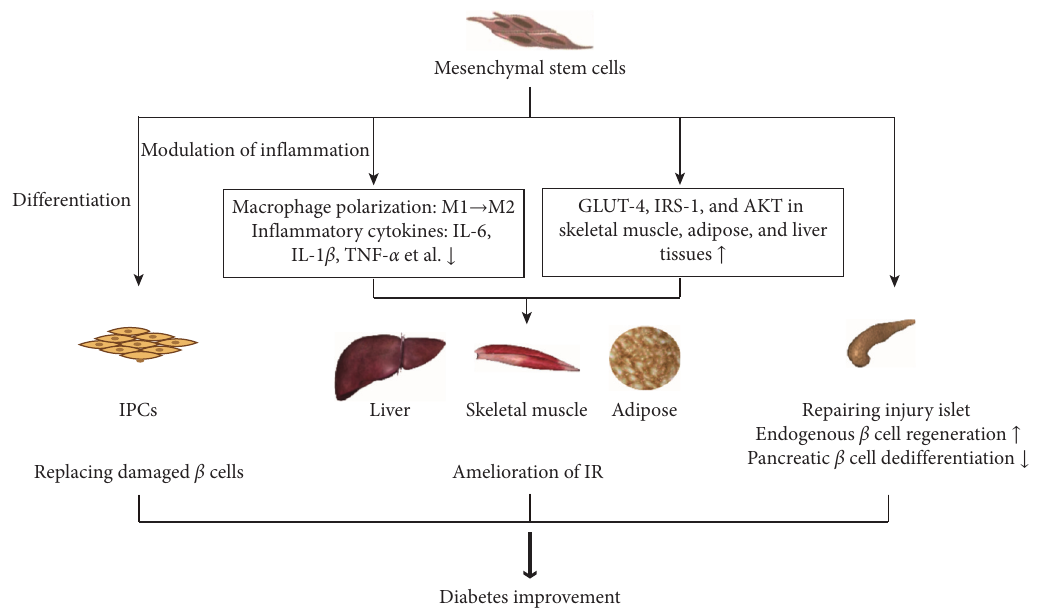
Figure 1: Mechanisms of MSC therapy for